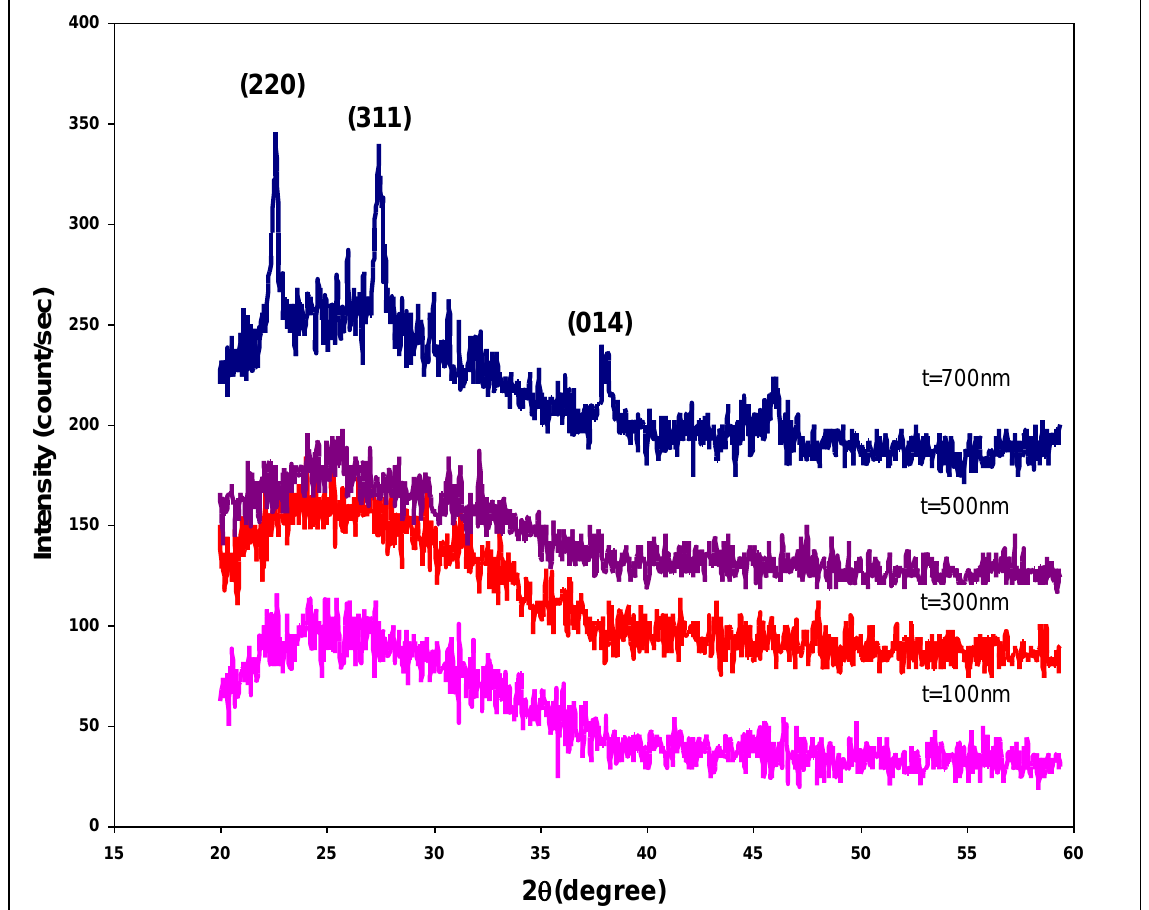
Fig. 1: XRD of as deposited Bi